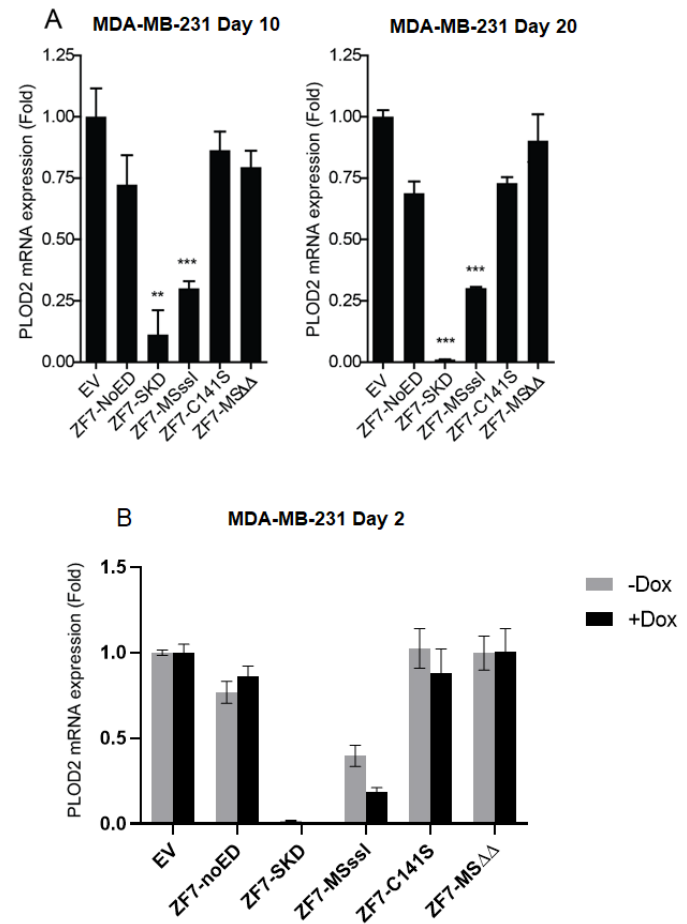
Figure 7. Repression of PLOD2 by targeting SKD or M.SssI to the PLOD2 promoter in transgenic MDA-MB-231 cells. ( A ) PLOD2 mRNA expression levels in MDA-MB-231 cells, engineered to contain the indicated transgenes, treated with doxycycline for 2 days and subcultured in normal medium for 10 and 20 days (mean ± SEM; n = 3, one-way ANOVA ** p < 0.01, *** p < 0.001). ( B ) PLOD2 mRNA expression levels in the transgenic MDA-MB-231 cells treated with or without doxycycline for 2 days and subcultured in normal medium for 2 days.